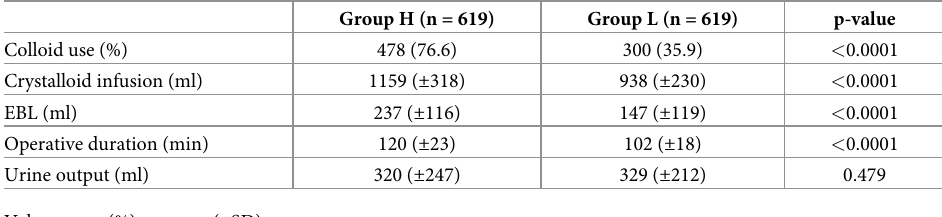
Table 3. Intraoperative variables in the propensity-matched